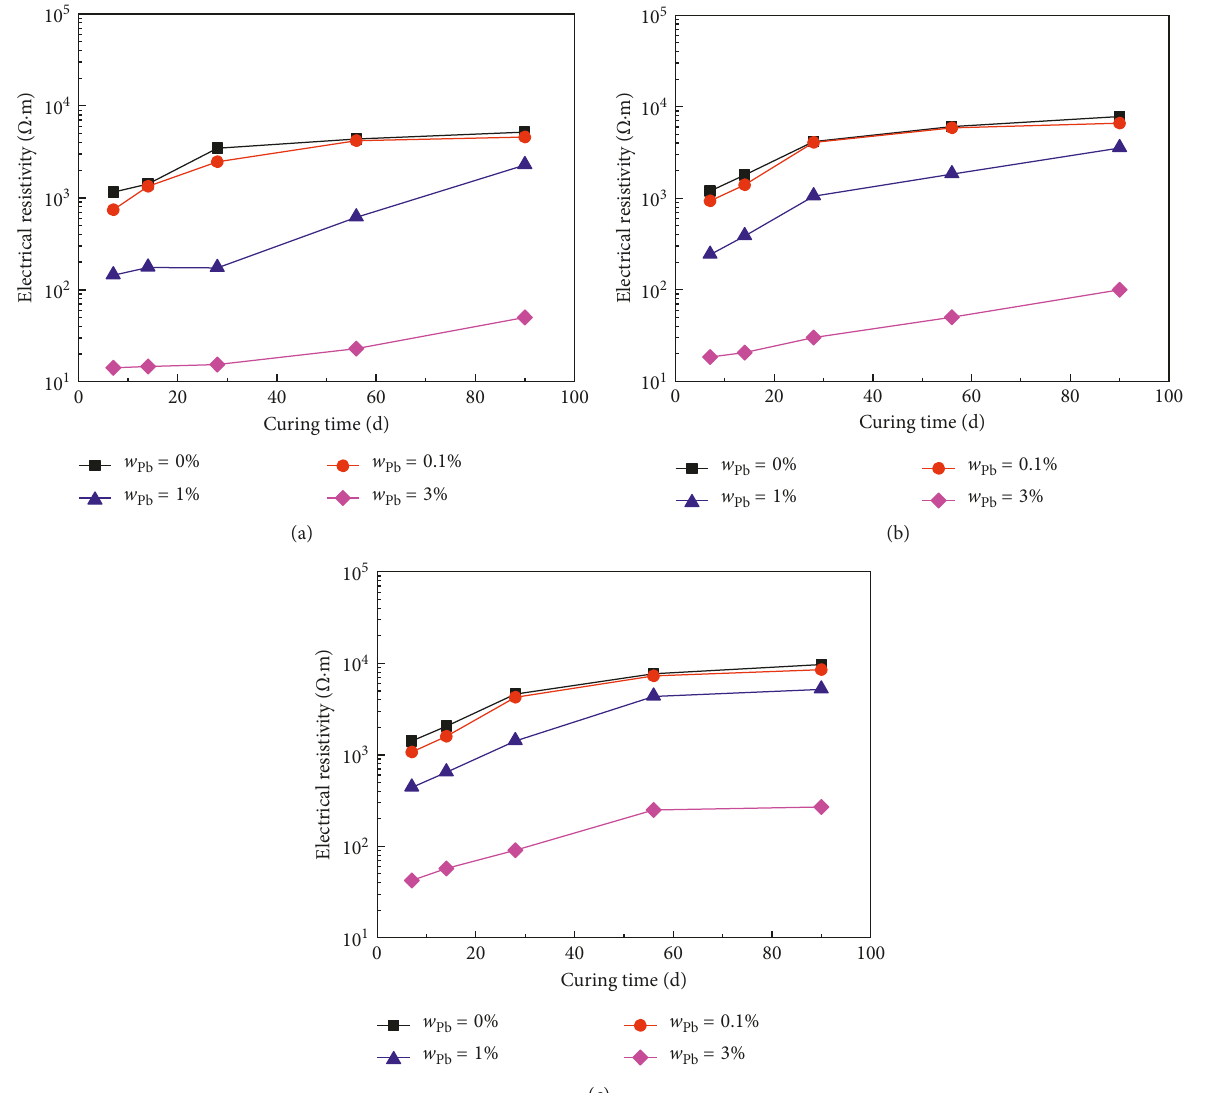
Figure 3: Variation of electrical resistivity with curing time of specimens of soil S1: (a) a